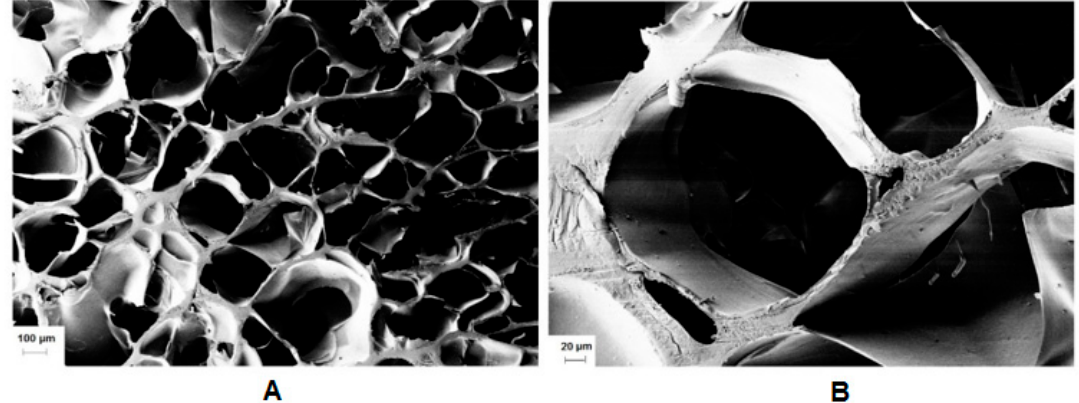
Figure 8. ( A ) SEM cross-sectional view of lyophilized gel obtained by photo crosslinking of HA-UDA (Mw = 240,000 g/mol; DS = 35%, 3.0 wt.%), and ( B ) detailed view of the pores. The cross-linking was mediated by Irgacure 2959 (scale bar: 100 and 20 µm, respectively).